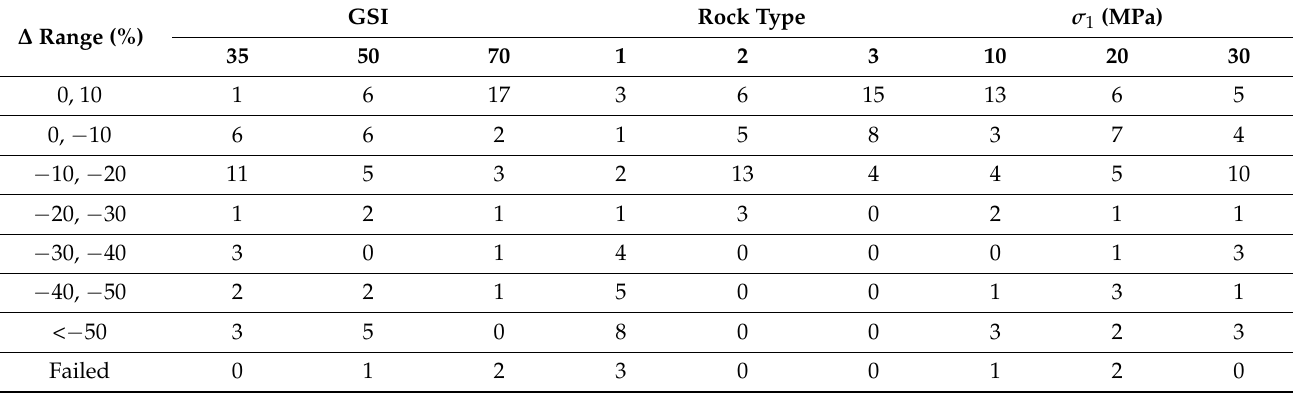
Table 5. Number of cases in the various error ranges for the number of yielded